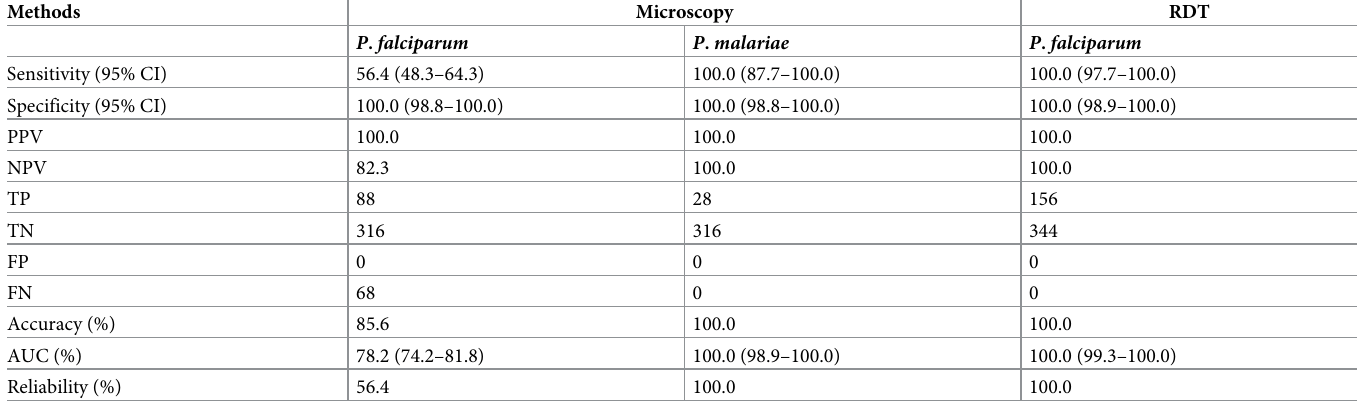
Table 5. Diagnostic performance of microscopy and RDT in detecting asymptomatic malaria